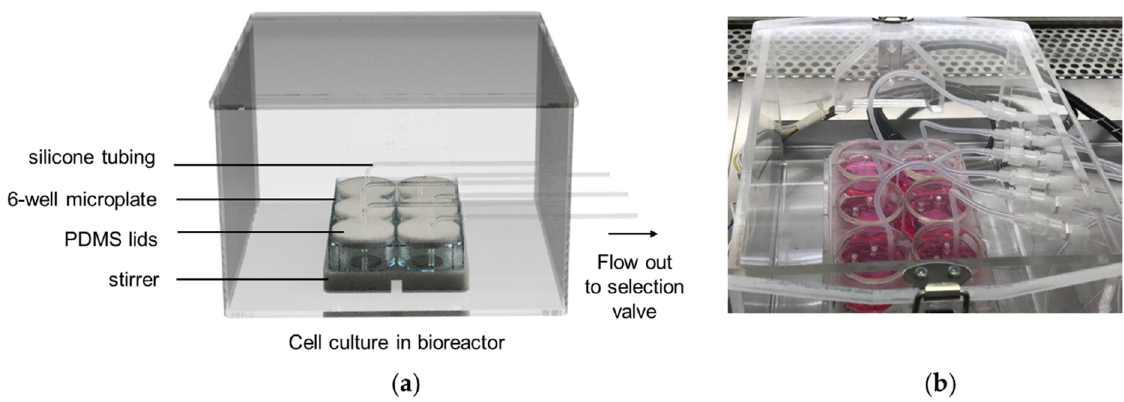
Figure 6. The bioreactor: ( a ) a computer ‐ aided design (CAD) file showing components of a bioreac ‐ tor; ( b ) a photograph of bioreactor with cell culture in a 6 ‐ well microplate. ( b ) a photograph of bioreactor with cell culture in a 6-well